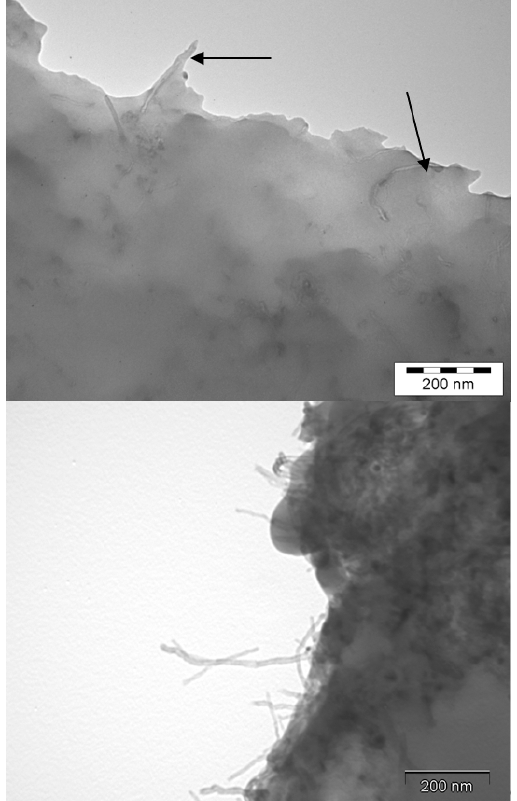
Figure 13. TEM micrographs on the fracture surfaces of DGEBA/DDS/MWNT nanocomposites (0.7 wt %) ( above ) After dispersion using a 3 roll-mill calander, ( below ) without pre-dispersion.